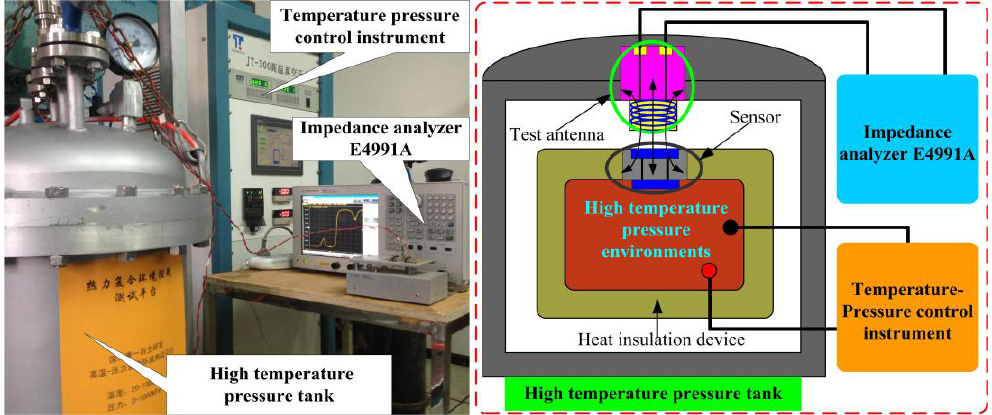
Figure 8. High-temperature pressure measurement system.